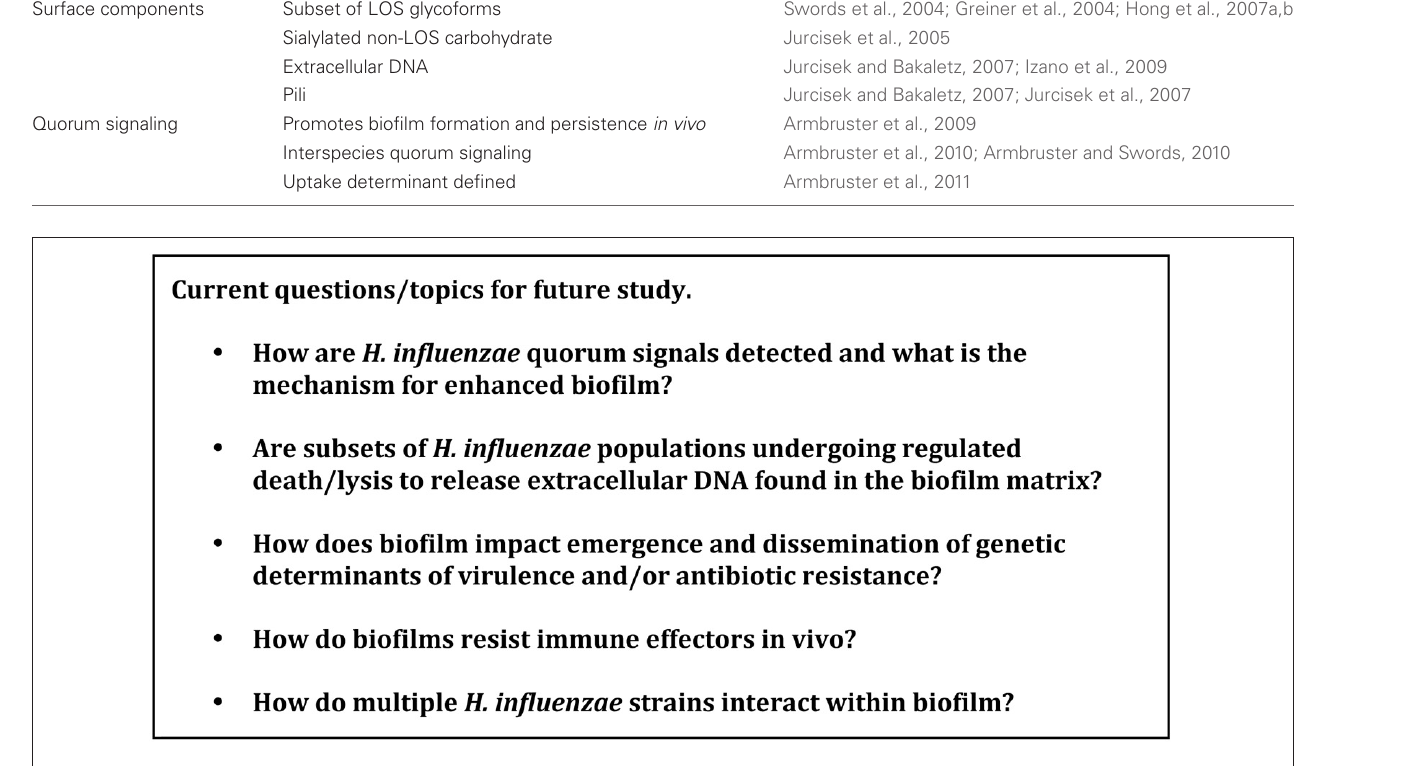
FIGURE 1 | Current questions/topics for future